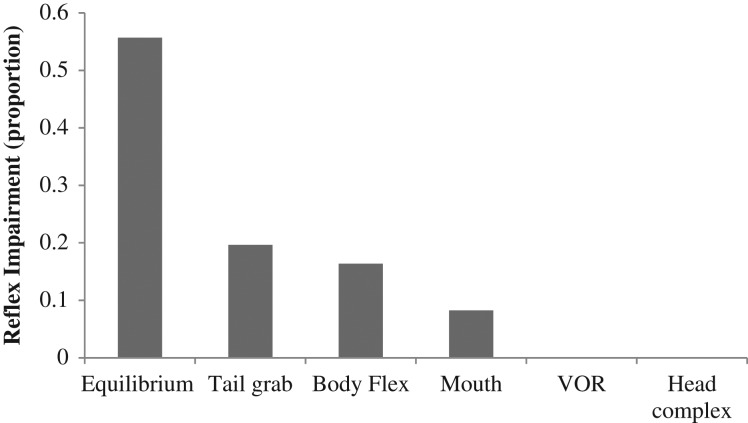
Contribution of each reflex action to impairment proportion.